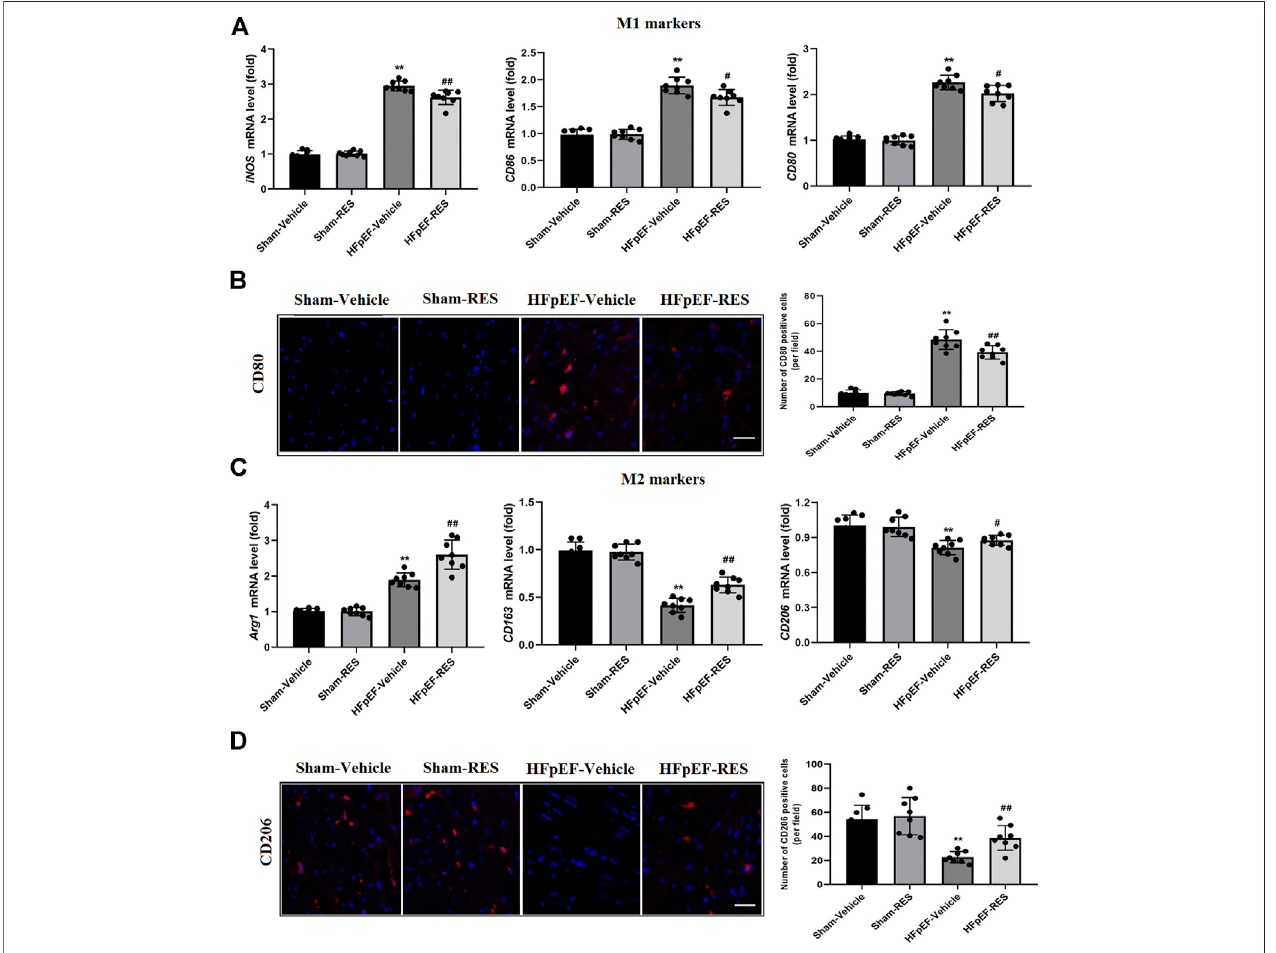
FIGURE 4| Effect ofRES on HFpEF-induced macrophage polarization. (A) Results ofmRNA expression of M1 markers iNOS , CD86 , and CD80 ( n (cid:2) 8 per group). (B) RepresentativeCD80immuno fl uorescencestainingandquantitativeresultsofthenumbersofCD80-positivecells( n (cid:2) 8pergroup). (C) ResultsofmRNAexpression of M2 markers Arg1 , CD163 , and CD206 ( n (cid:2) 8 per group). (D) Representative CD206 immuno fl uorescence staining and quantitative results of the numbers of CD206- positive cells ( n (cid:2) 8 per group). * p < 0.05 vs. sham-vehicle group. ** p < 0.01 vs. sham-vehicle group. # p < 0.05 vs. HFpEF-vehicle group. ## p < 0.01 vs. HFpEF- vehicle group. Scale bars, 50